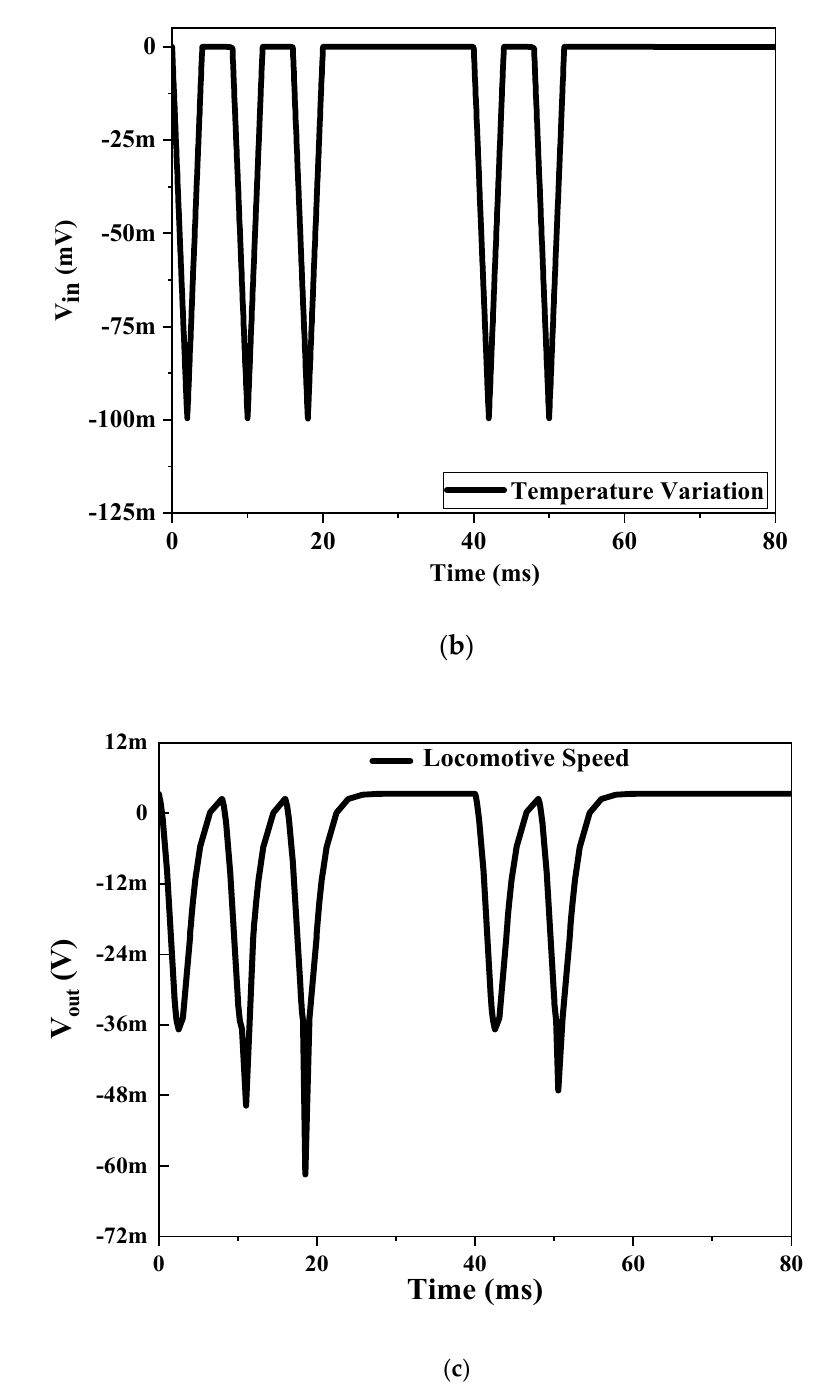
Figure 20. Proposed memristive model‑based ( a ) adaptive amoeba‑learning circuit ( b ) input voltage pulse ( c ) acquired speed